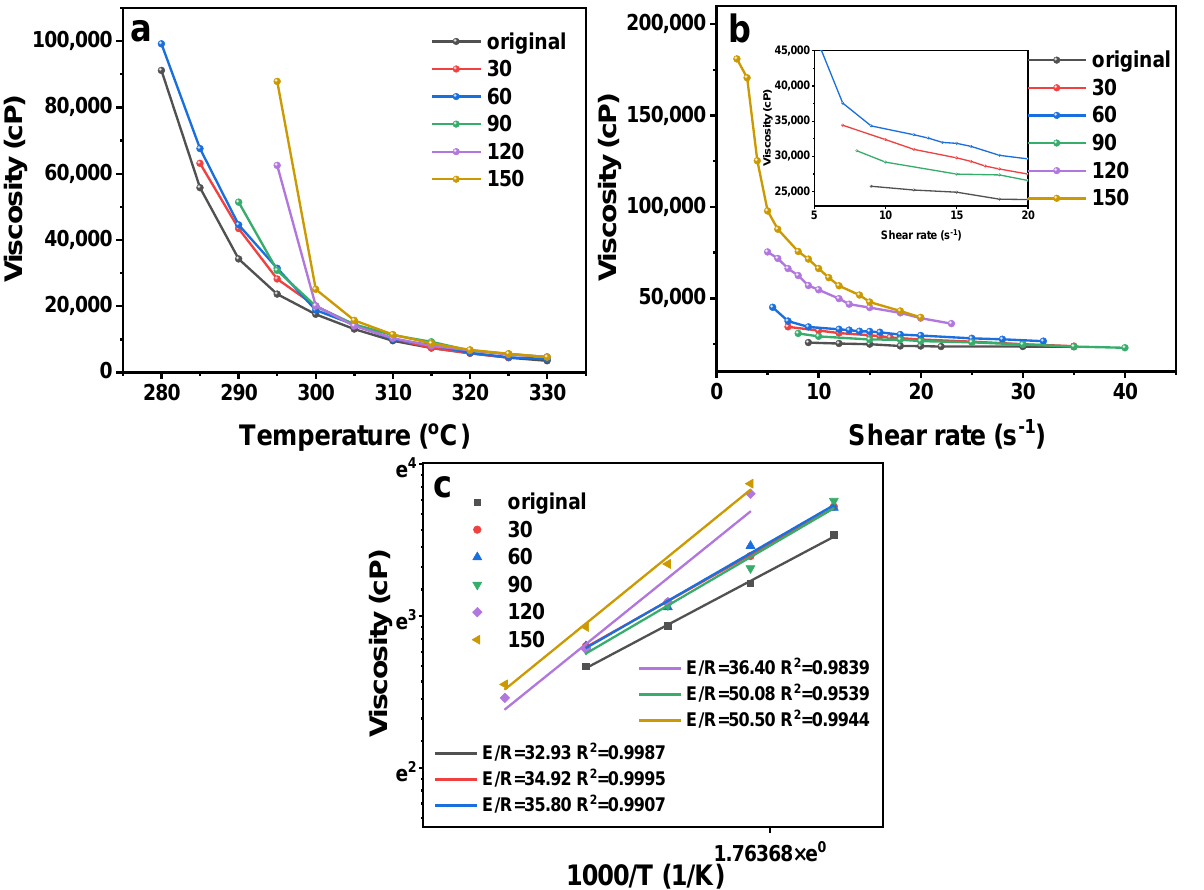
Figure 16. Rheological properties of the spinnable pitch. ( a ) The viscosity-temperature curves of spinnable pitch. ( b ) Viscosity change curves with shear rate of spinnable pitch at 295 °C. ( c ) Graph of viscosity with temperature at a shear rate of 20 s −1 .